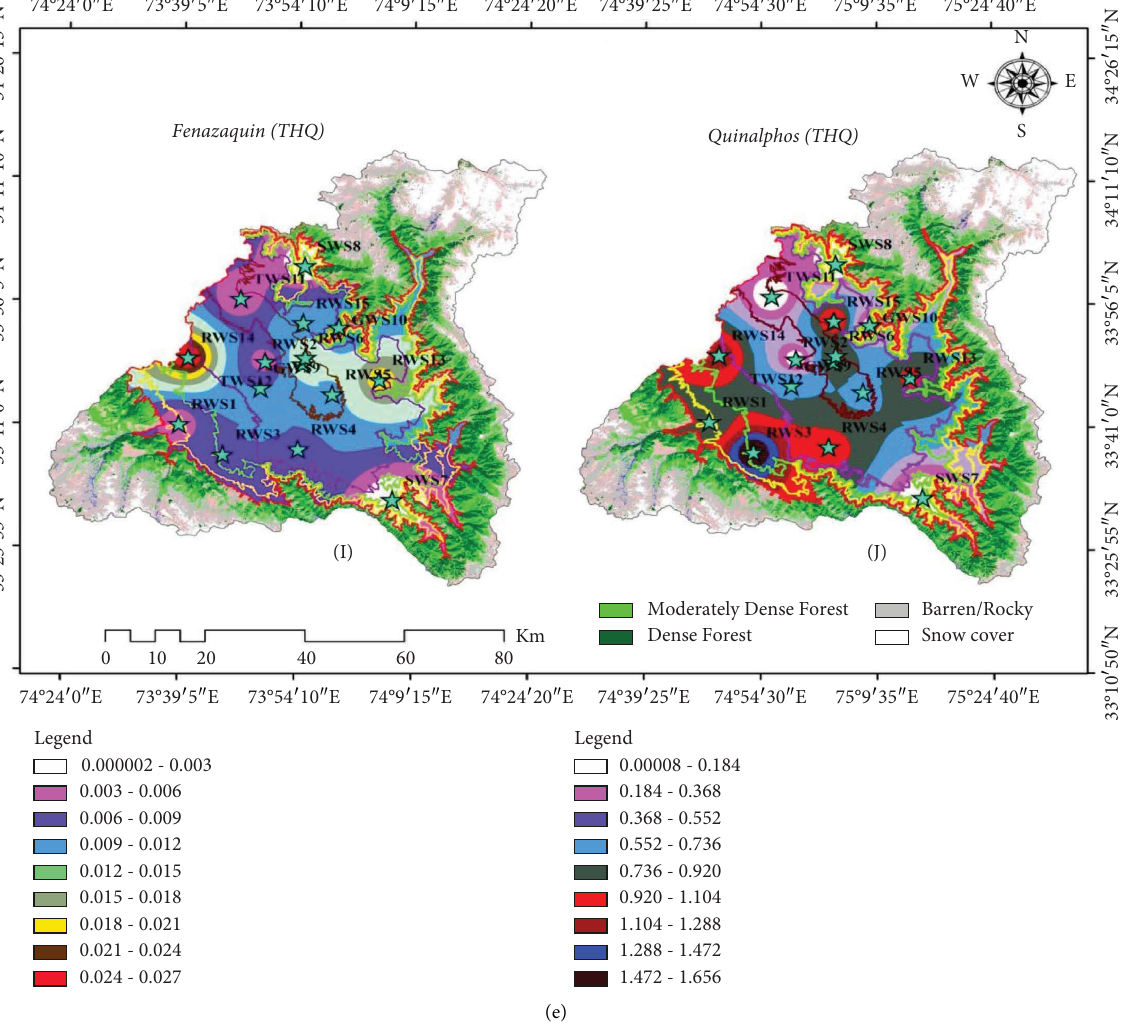
Figure 2: (a) Interpolation diagrams (A and B) showing spatial distribution of detected pesticides in the study area. (b) Interpolation diagrams (C and D). (c) Interpolation diagrams (E and F). (d) Interpolation diagrams (G and H). (e) Interpolation diagrams (I and